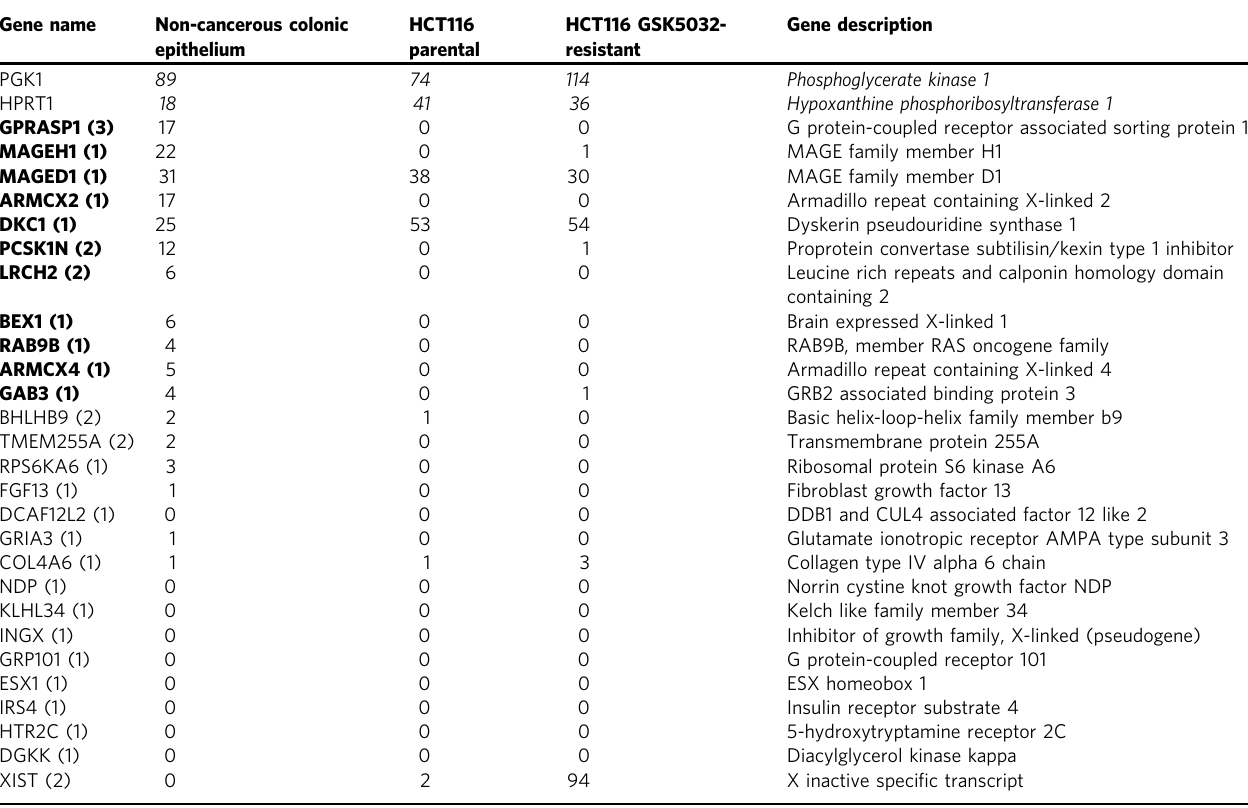
Table 1 Transcripts per million (TPM) for genes with promoter probes that remain methylated ( β -value ≥ 0.7) after longterm GSK5032 treatment in HCT116 cells that are methylated in cancer on the X